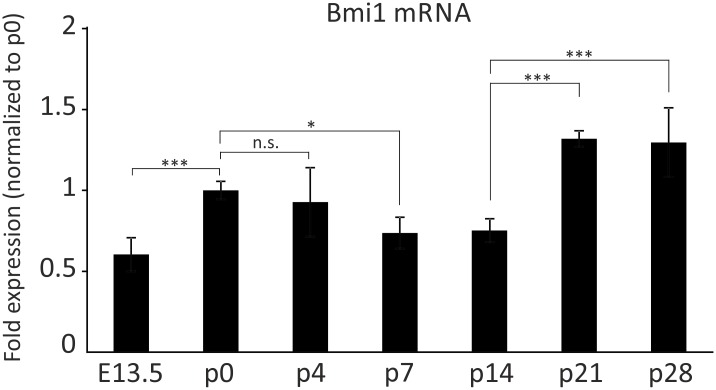
Quantitative analysis of the temporal Bmi1 expression pattern in the cochlear sensory epithelium during development.Bmi1 mRNA levels in the cochlear sensory epithelium at seven developmental stages: E13.5, p0, p4, p7, p14, p21 and p28. Bmi1 transcripts were detected in the sensory epithelium at all stages. All values were normalized to the p0 level. Bmi1 mRNA levels significantly increased between E13.5 and p0. Subsequently, Bmi1 mRNA was significantly downregulated between p0 and p7, which was followed by a statistically significant upregulation at p21 and p28. n.s.: not significant. *p<0.05, ***p<0.001.